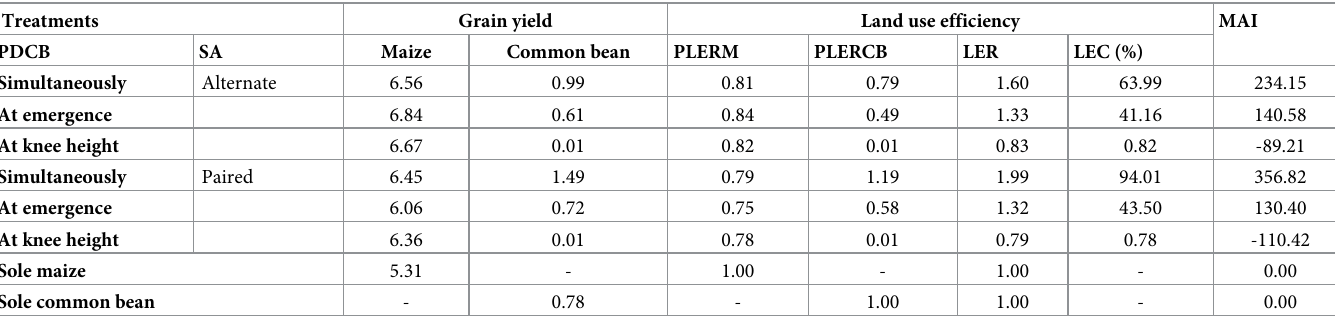
a Data were combined over years (2014 and 2016). PDCB, Planting date of common bean with maize in a mixture; SA, spatial arrangements of the component crops; PLERM = partial land equivalent ratio of maize; PLERCB = partial land equivalent ratio of common bean; LER = land equivalent ratio; LEC = land equivalent coefficient; MAI = monetary advantage